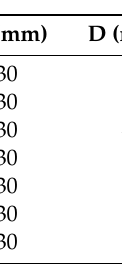
Table 4. Group 4: Constant width (30 mm) with variable center holes.